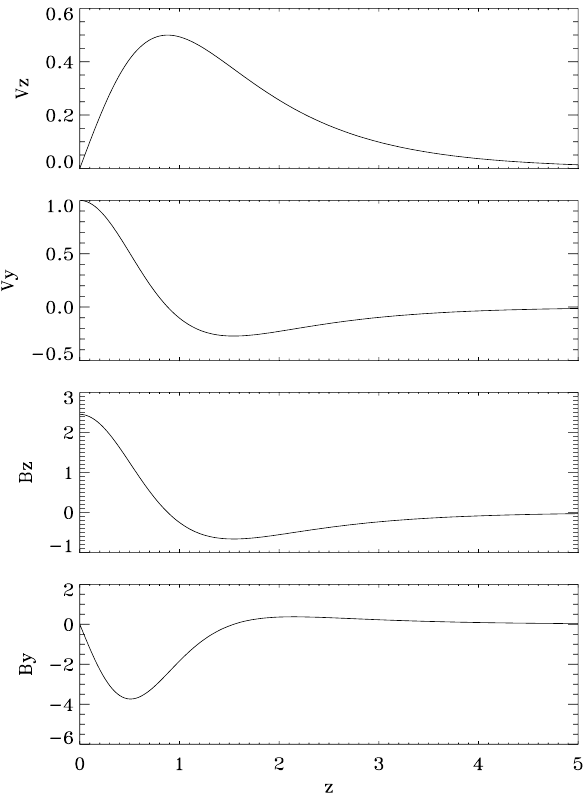
Fig. 6. Frequencies, group and phase velocities in the case of non- constant density